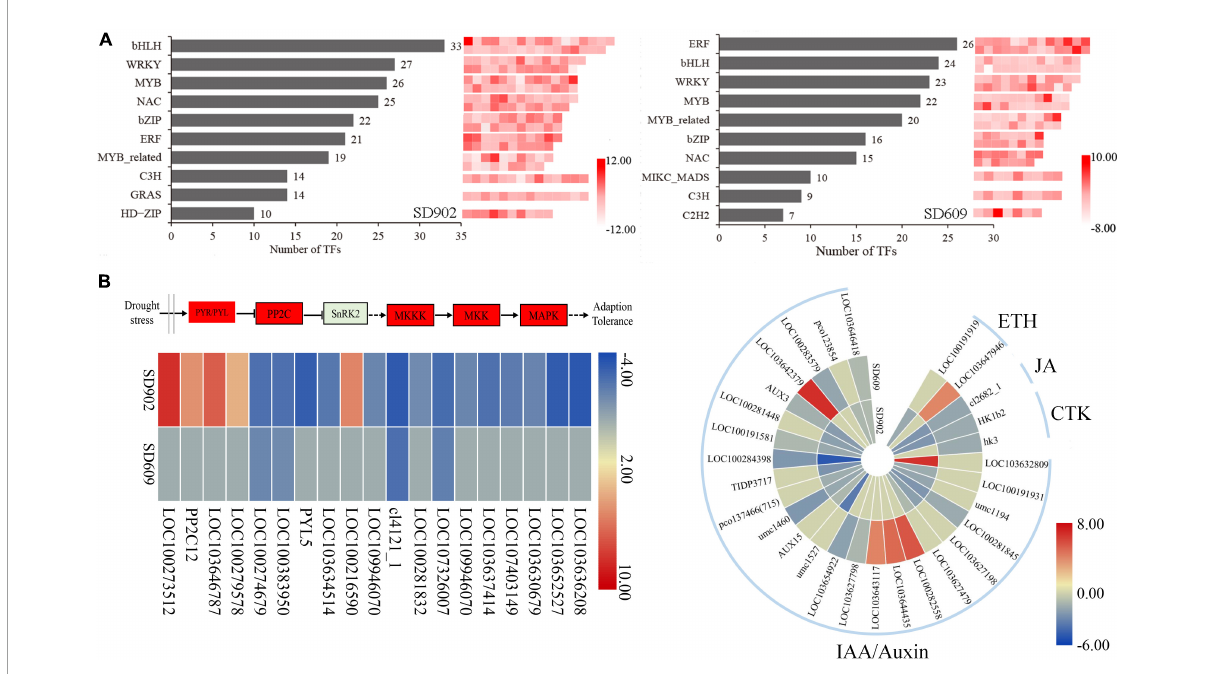
FIGURE5 Expression levels of differentially expressed genes (DEGs) involved in transcription factors, MAPK, and plant hormone signaling between SD902 and SD609 based on log2 (FC) value. (A) Top 10 transcription factor families and the number of corresponding members. (B) Signal transduction of MAPK and plant hormone-related genes during drought